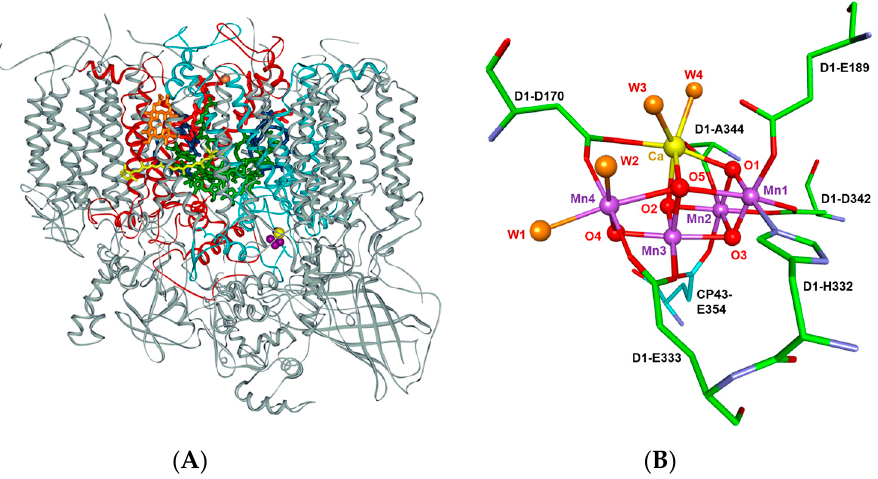
Figure 1. ( A ) The multi-subunit membrane protein complex, photosystem II (PSII), as observed in the 1.9 Å resolution X-ray crystal structure and ( B ) the tetranuclear manganese-calcium-oxo (Mn 4 CaO 5 ) catalytic cluster in the oxygen-evolving complex (OEC) of PSII [10]. The manganese (Mn1–Mn4), O 2 − (O1–O5), and Ca 2+ ions are depicted as purple, red, and yellow spheres, respectively. The oxygen atoms of the four water-derived ligands that are coordinated to the Mn 4 CaO 5 cluster, W1–W4, are shown in orange, where W1 and W2 are coordinated to the dangling Mn ion, Mn4, and W3, and W4 are ligands to the Ca 2+ ion. The amino acid residues that are coordinated to the metal ions of the Mn 4 Ca-oxo cluster in the OEC are also